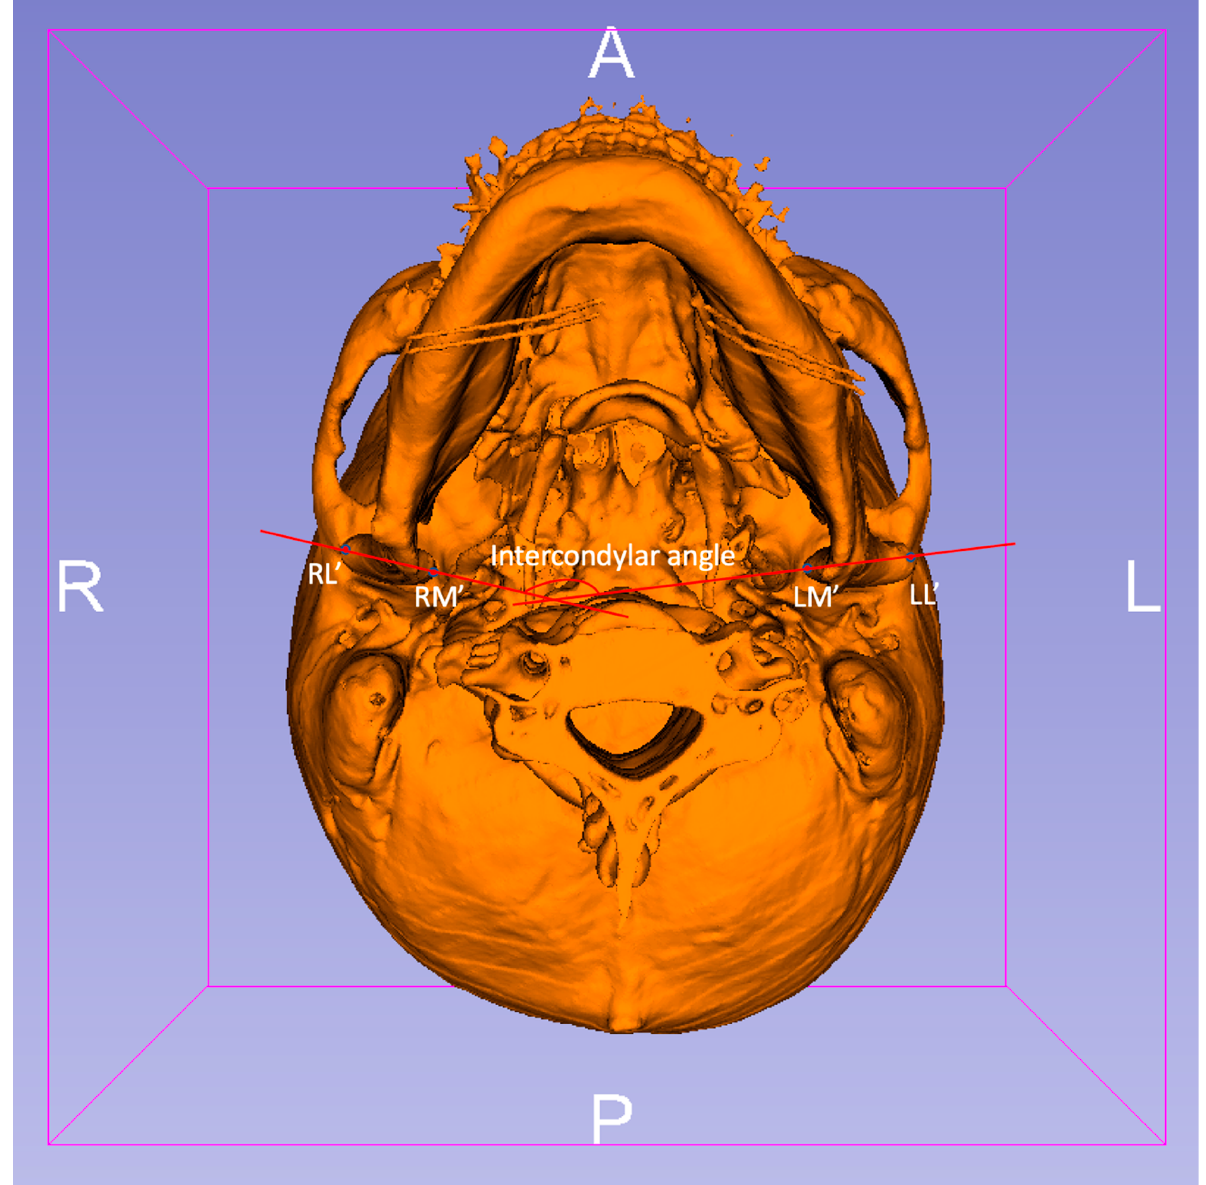
Figure 4. The postoperative (T2) 3D imaging of the inferior view of the presurgical mandible and cranial base. RL’ (right), LL’ (left)—most lateral point of the condyle, RM’ (right), LM’ (left)—most medial point of the condyle were identified. The cutting angle between the axes (RL’-LM’ and RM’-LL’), also called the intercondylar angle, was calculated and measured.